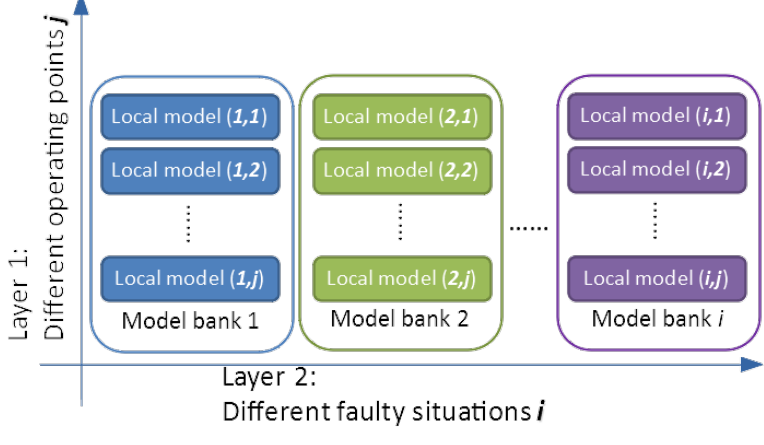
Figure 5. Two-layer multiple